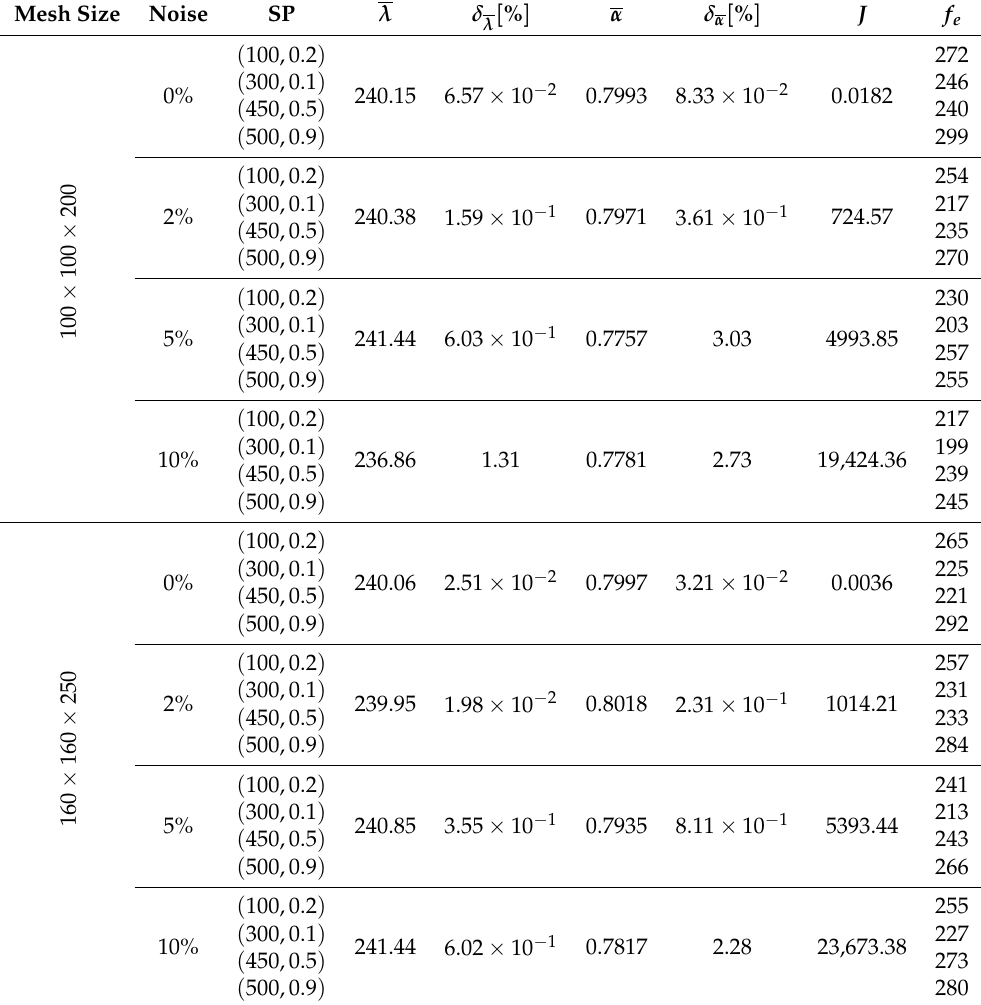
Table 2. Results of calculations in case of Hooke–Jeeves algorithm: λ —reconstructed value of thermal conductivity coefficient; α —reconstructed value of x -direction derivative order; δ —the relative error of reconstruction; J —the value of objective function; f e —number of evaluation objective function; SP —starting